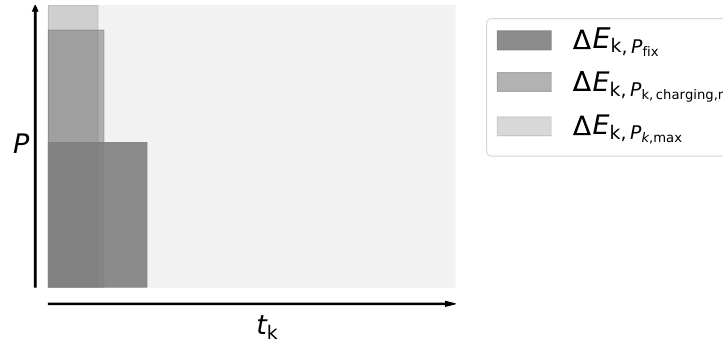
Figure 12. FlexBars for the office site.